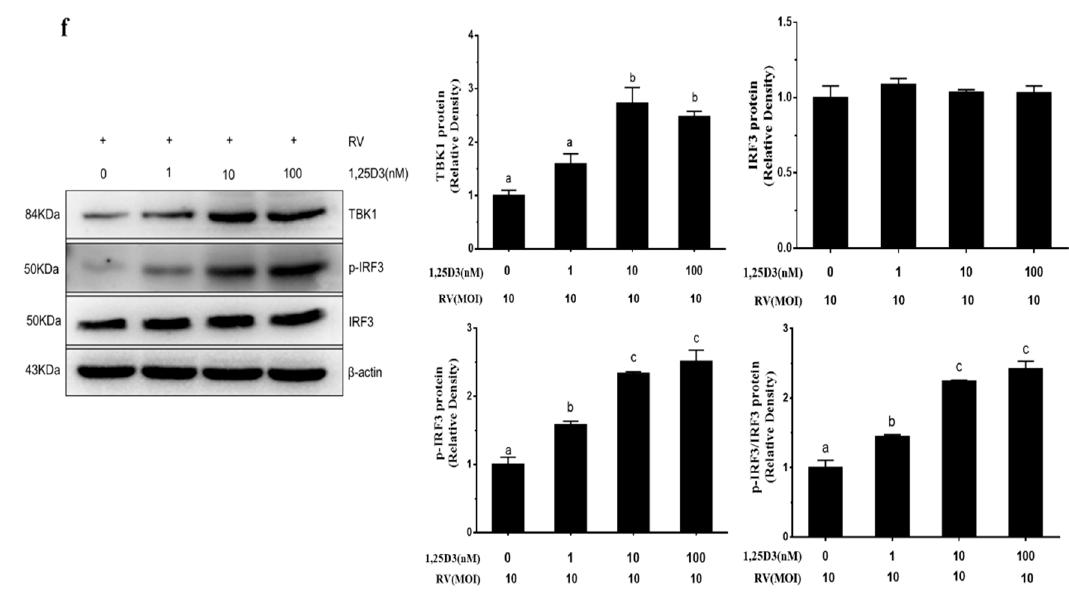
Figure 2. 1,25D3 inhibits RV infection via the TBK1/IRF3 signaling pathway in RV-infected IPEC-J2. The effect of 1,25D3 on RV ( a ), RV antigen ( b ) , TBK1( c ), IRF3 ( d ), and IFN- β ( e ) mRNA expressions, and TBK1, IRF3, and p-IRF3 ( f ) protein levels. All data were expressed as means ± SD (bars represent the SD from three independent experiments). a,b,c : Means with different letters on vertical bars indicate significant differences ( p < 0.05).